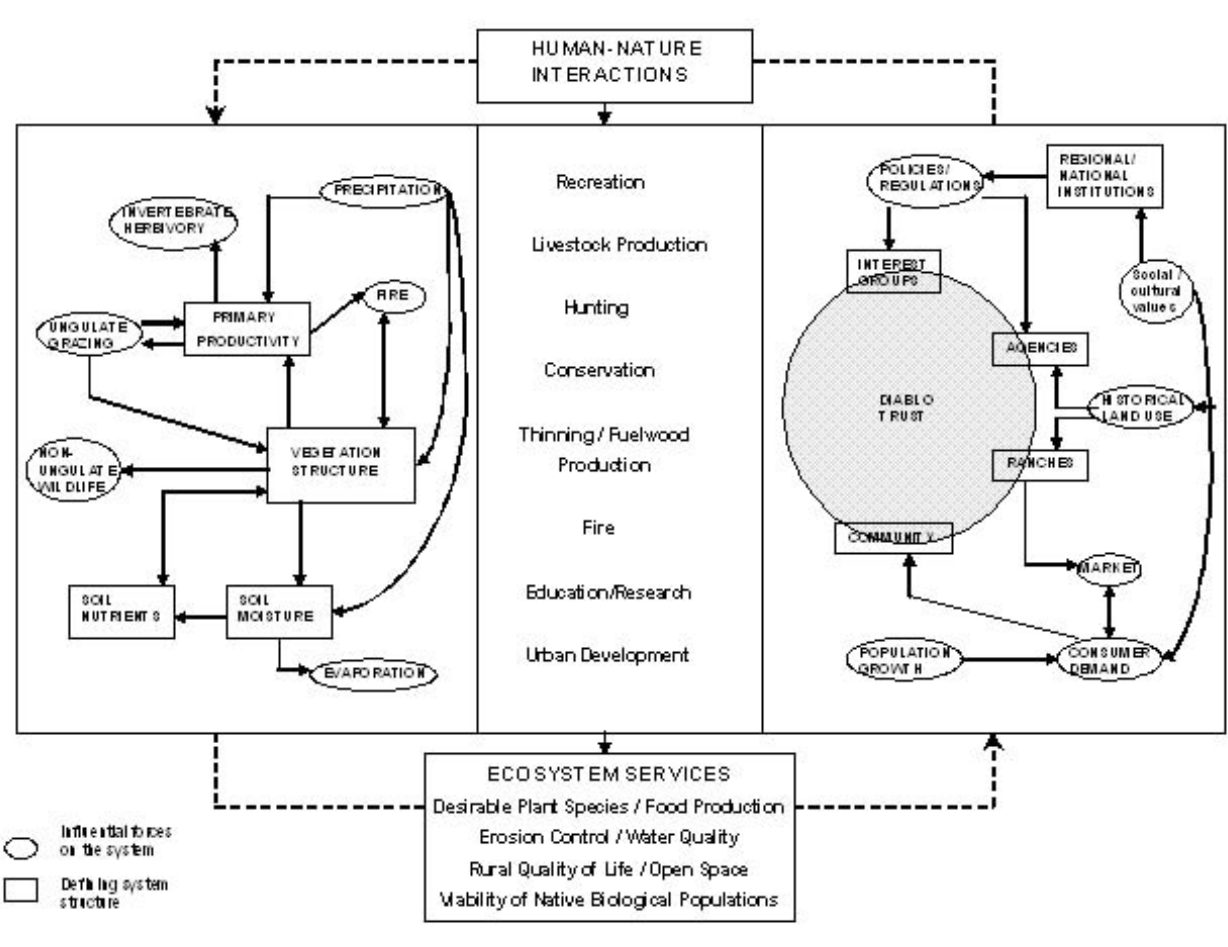
Fig. 3. The conceptual model developed for the Diablo Trust management unit (see Muñoz-Erickson